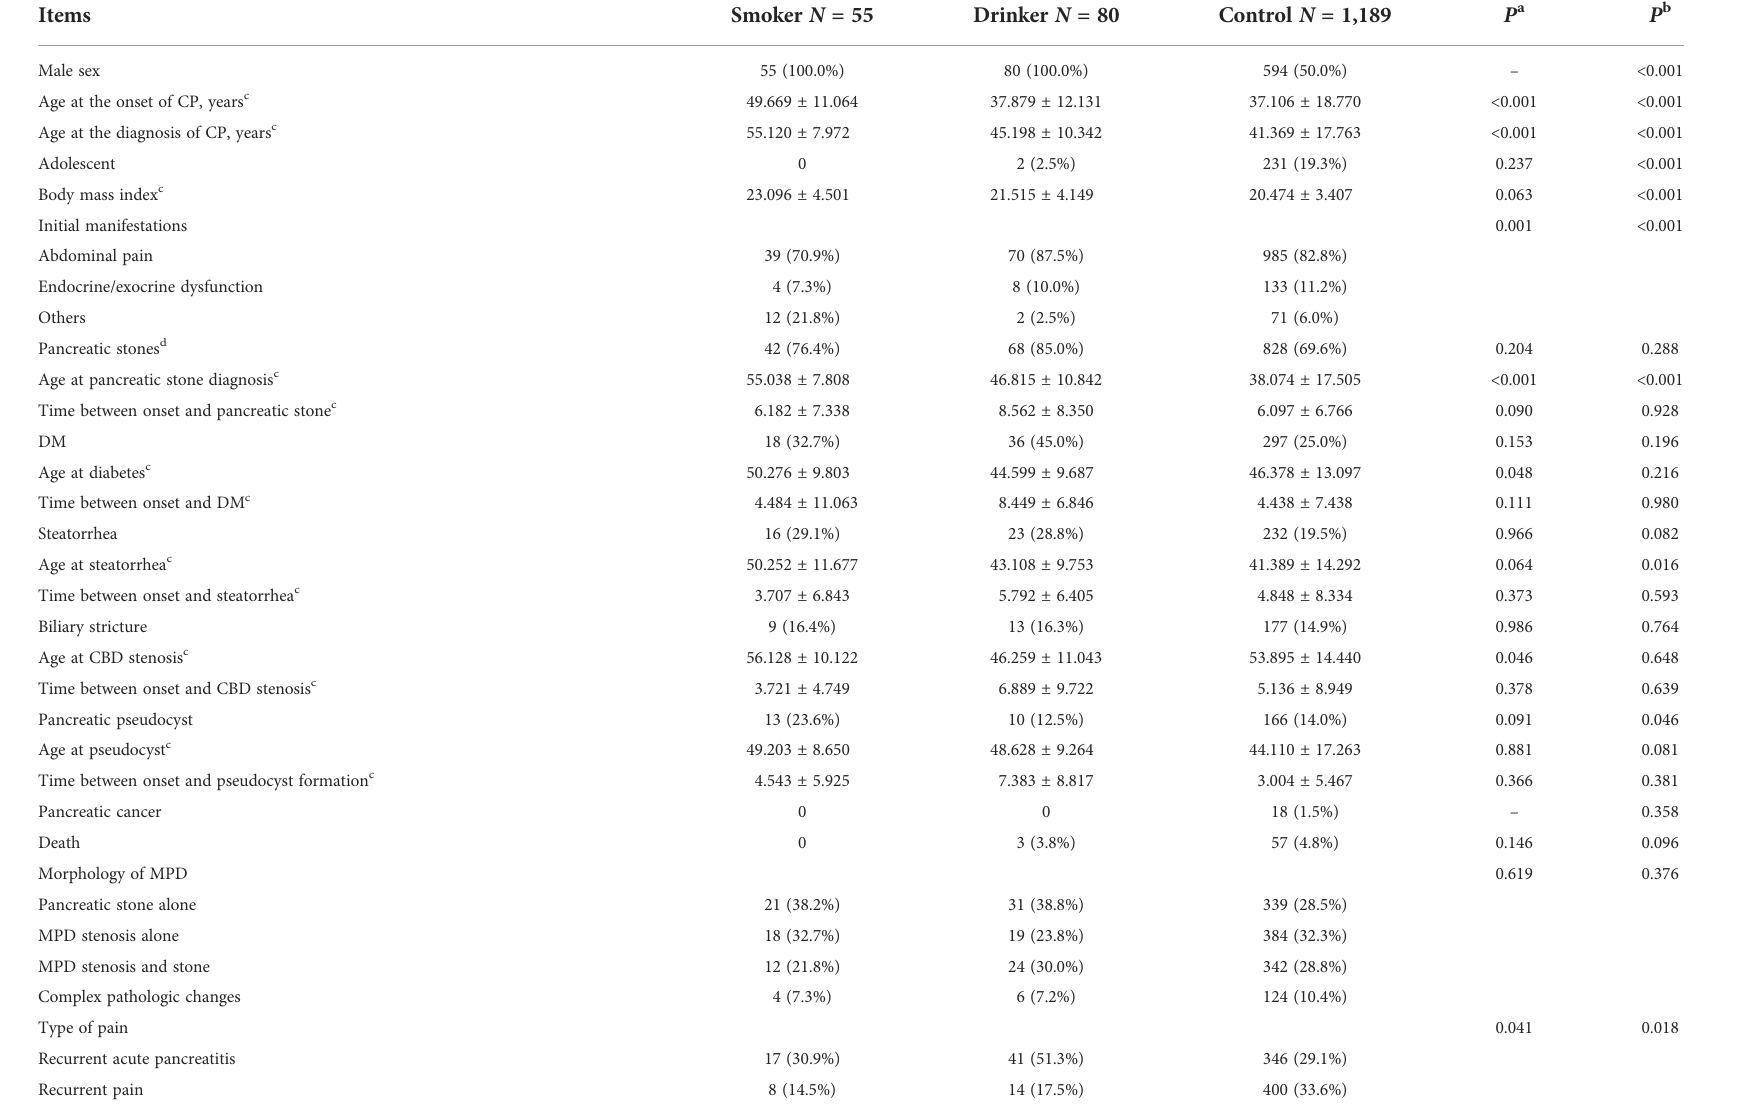
TABLE 2 General characteristics of 1,324 patients with